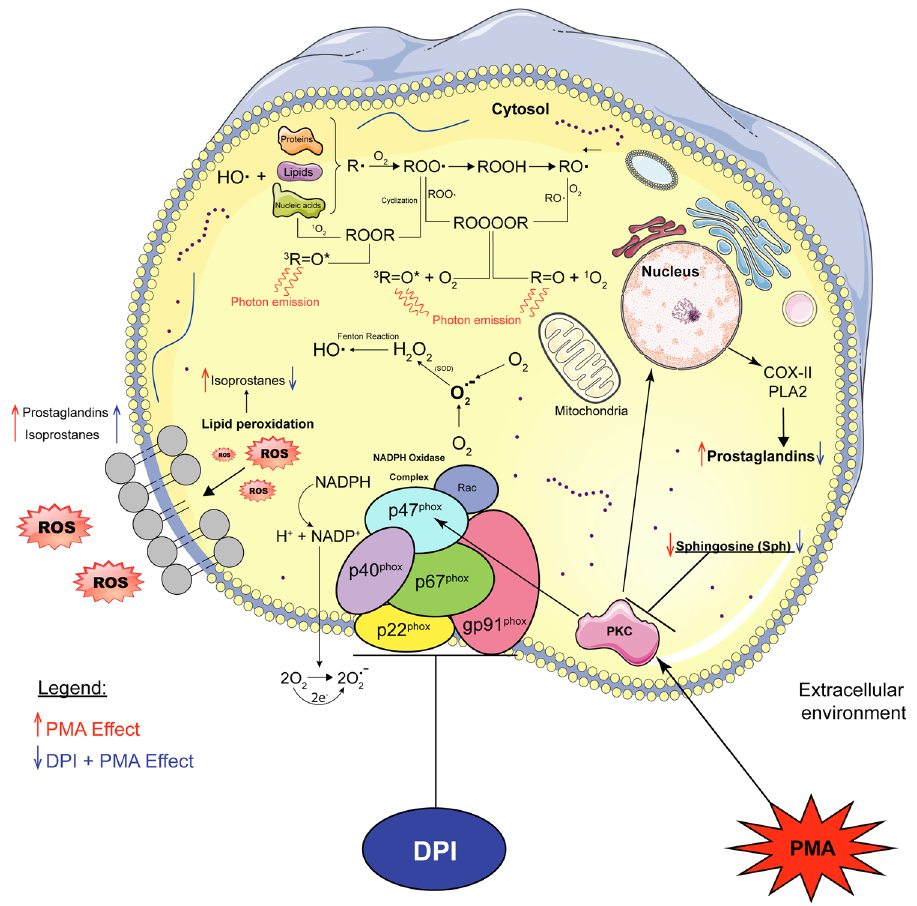
Figure 4. Schematic overview of the biological events involved in NADPH oxidase during PMA-induced respiratory burst in differentiated HL-60 cells. PMA activates protein kinase C (PKC), which signals to the nucleus, activating cyclooxygenase (COX) and phospholipase A 2 (PLA2) pathways, leading to the production of prostaglandins. O 2. − is first produced by NADPH oxidase as a primary ROS and is subsequently dismutated to H 2 O 2 by superoxide dismutase (SOD). Thus, H 2 O 2 serves as a substrate for generating hydroxyl radicals (OH • ) via the Fenton reaction. Hydroxyl radicals (OH • ) are potent oxidants that can produce the initial